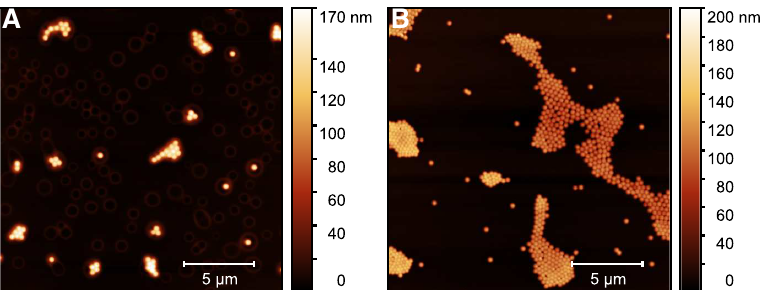
Figure A5. UV/Vis measurements of the supernatants of the loaded microgels at 20°C to study the bleeding of CBD after centrifugation and the re-addition of ethanol ( A ). Supernatant of the loaded microgels (20°C) after centrifugation and the addition of water ( B ).